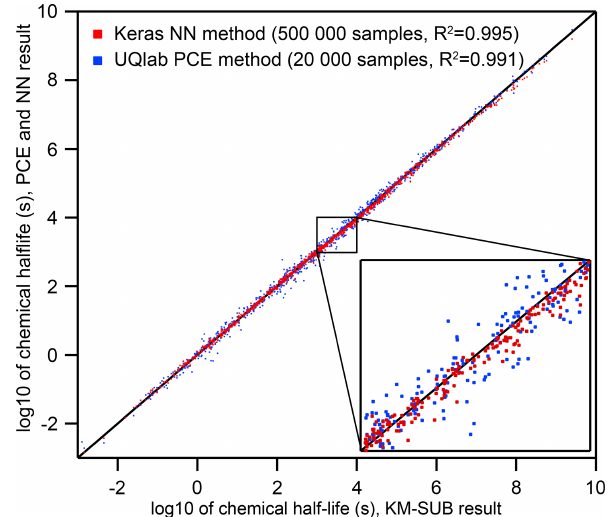
Figure 2. Comparison of the two surrogate models predicting the chemical half-life for heterogeneous chemistry on aerosol particles for a wide range of KM-SUB output ( N = 1000 – test dataset not part of the training dataset). The surrogate models were trained on 20000 (PCE) and 500000 (NN) KM-SUB data samples, respec- tively. Training times of models with this complexity fall below an upper feasibility range on a personal computer within a few days of time. The inset shows a magnified section and spans from chemical half-lives of 10 3 s ( ≈ 15min) to 10 4 s ( ≈ 3h), a common range for laboratory